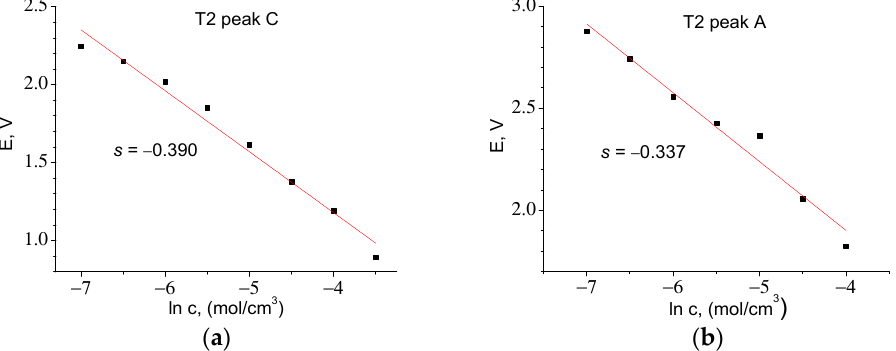
Figure 12. Experimental dependences of E = f(ln c ) for T2 series samples: ( a ) for cathodic ( z = 0.066) and ( b ) for anodic ( z = 0.076) parts of CVA. Table 6. Diffusion coefficient values for T1 and T2 electrodes (second cycle v = 0.05 mV/s).